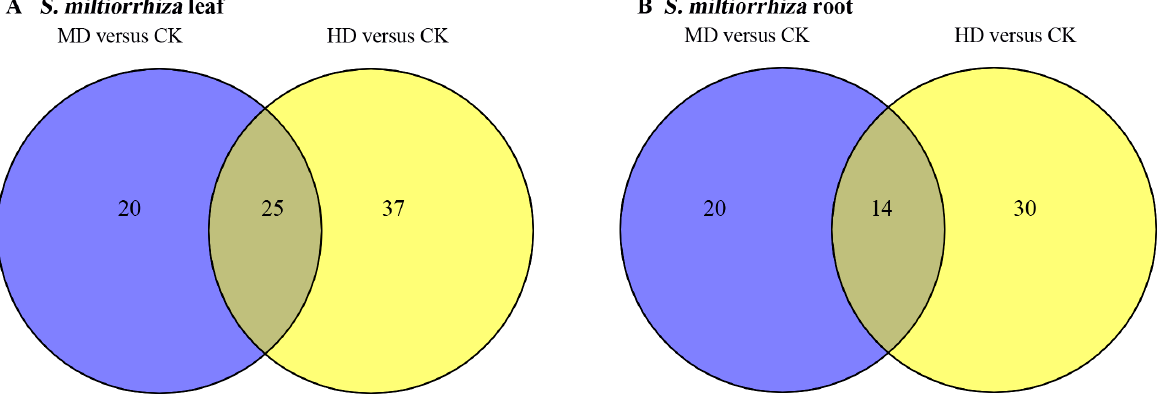
Figure 2. The Venn diagram of differential metabolites in Salvia miltiorrhiza Bunge . ( A , B ): the Venn diagram indicating differential metabolites in S. miltiorrhiza leaf and root, respectively. Differential metabolites were identified using the thresholds of fold change (FC) ≥ 1.5 or ≤ 0.67 (|log2FC| ≥ 0.585) and p < 0.05. Table 1. Significantly differential metabolites in Salvia miltiorrhiza Bunge leaf and root induced by drought stress by univariate statistics.